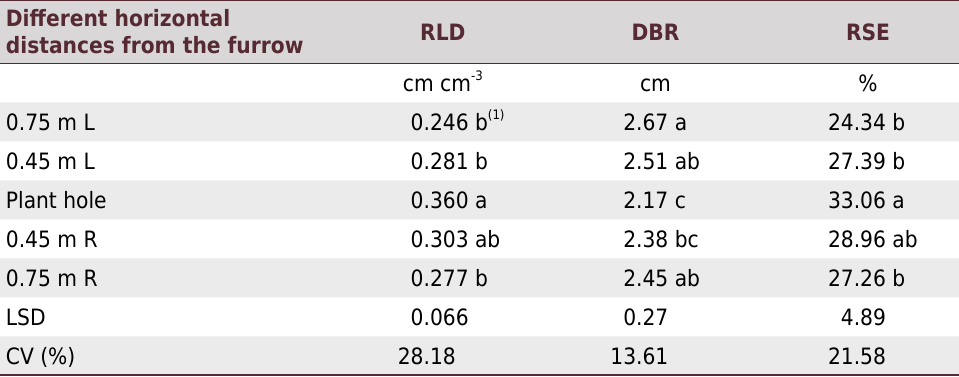
(1) Mean values followed by different letters in the column differ statistically at distances from the furrow by Tukey’s test at 1 % significance. Depth 0.75 m (0.45 to 0.75 m); 0.45 m (0.15 to 0.45 m). R = right; L = left of the plant